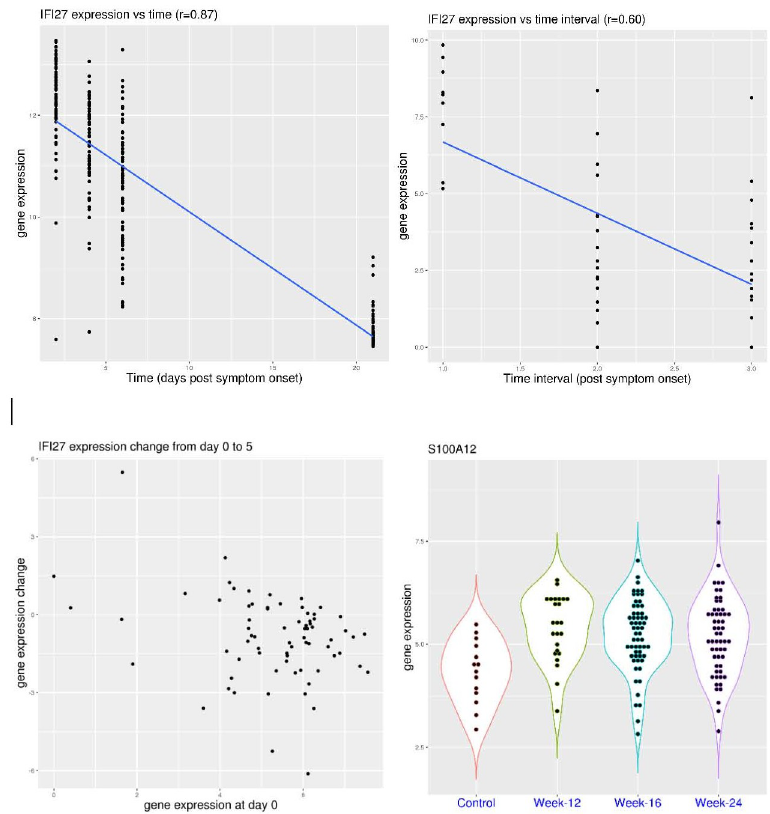
Fig 7. Longitudinal tracking of the expression level of IFI27 and S100A12 during the course of infection. A) upper left (dataset GSE68310), tracking of IFI27 expression in a community cohort with seasonal influenza. B) upper right (dataset GSE161731), tracking of IFI27 expression in non-hospitalized patients with COVID-19. C) lower left (dataset GSE178967), change of IFI27 expression in COVID-19 patients 5 days after study enrollment. D) lower right (dataset GSE169687), long-term tracking of S100A12 expression in COVID-19